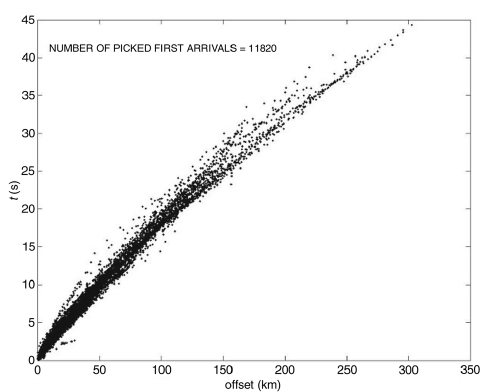
Fig. 5. Travel time versus offset of the P -wave first arrivals with reduction velocity 8 km/s.